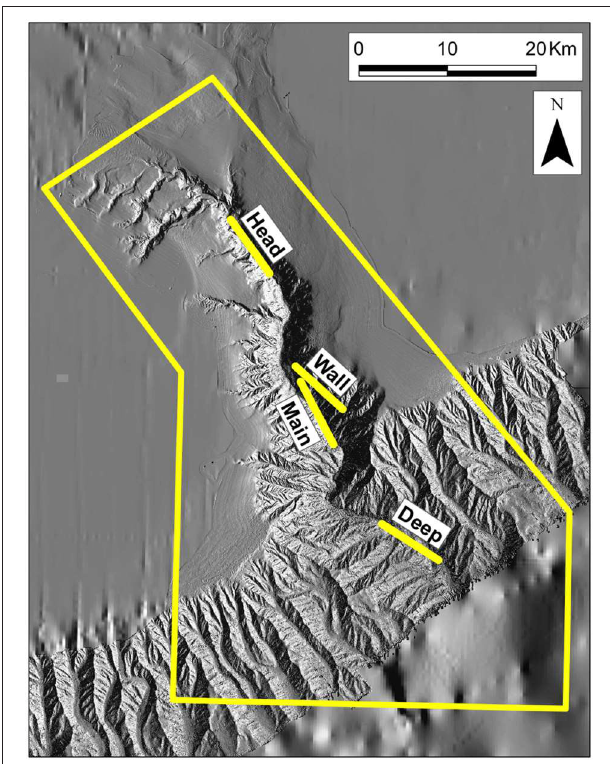
FIGURE 2 | Bathymetry of The Gully, showing the locations of four trawling stations: The boundary of the MPA is in yellow.